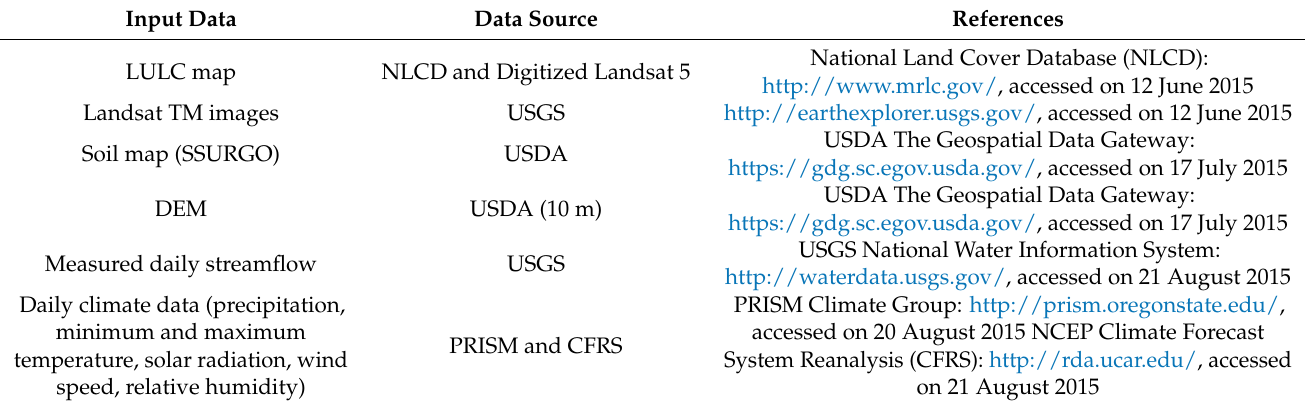
Table 3. Input data used in the SWAT model and data